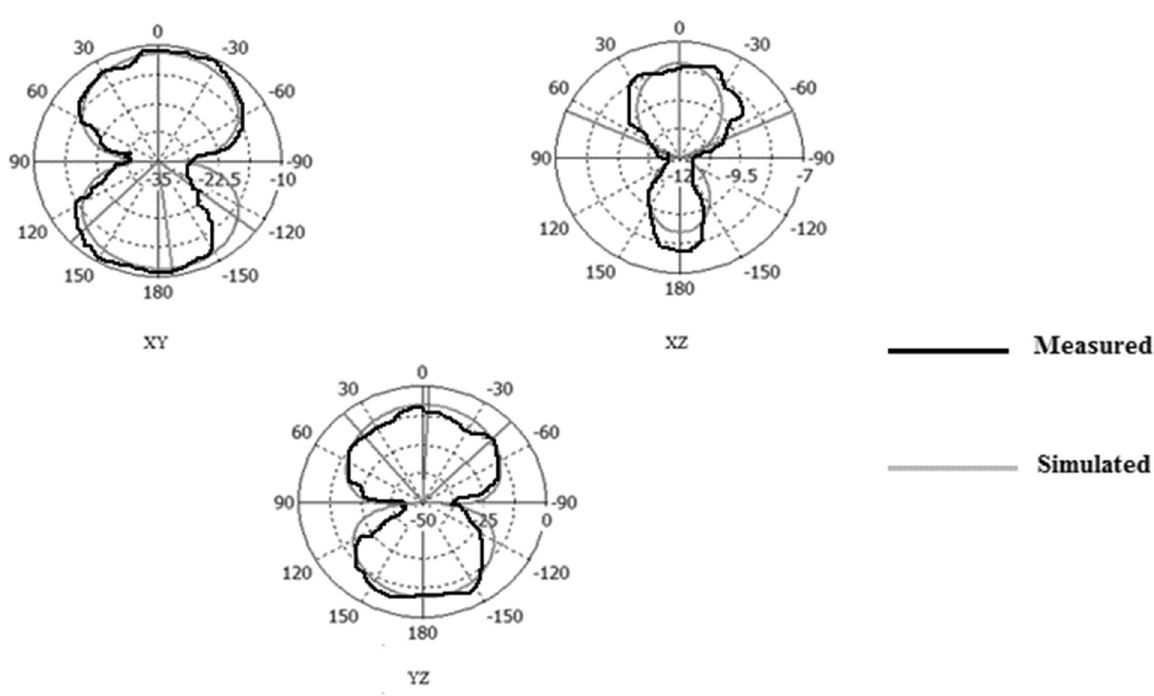
Figure 31. Simulated and measured radiation patterns of Antenna1 at the fundamental frequency of 2.7 GHz.